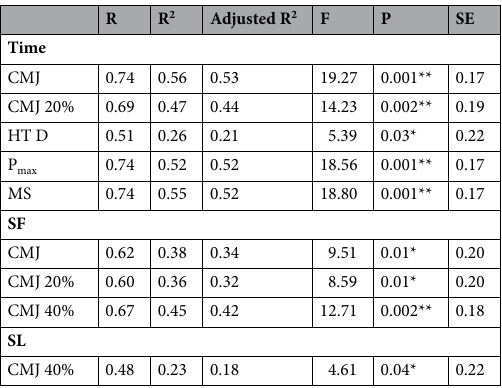
Table 3. Values of regression analysis explaining the relevance of different sprinting variables (time, SF, and SL). *Significance at p < 0.05. **Significance at p <